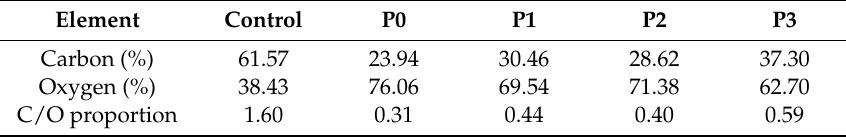
Table 4. Carbon/oxygen proportion of zirconia after plasma treatment.